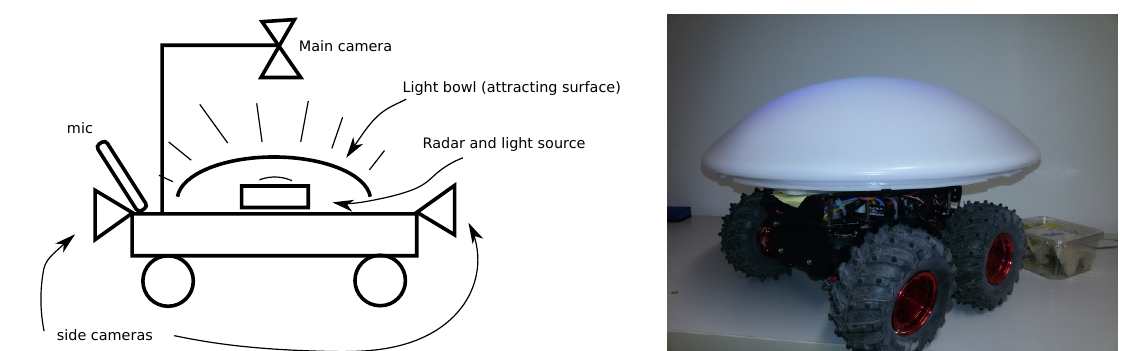
Figure 7. Insect radar and rover: ( left ) a concept; ( right ) a mockup installation with a rover, radar, and light trap.